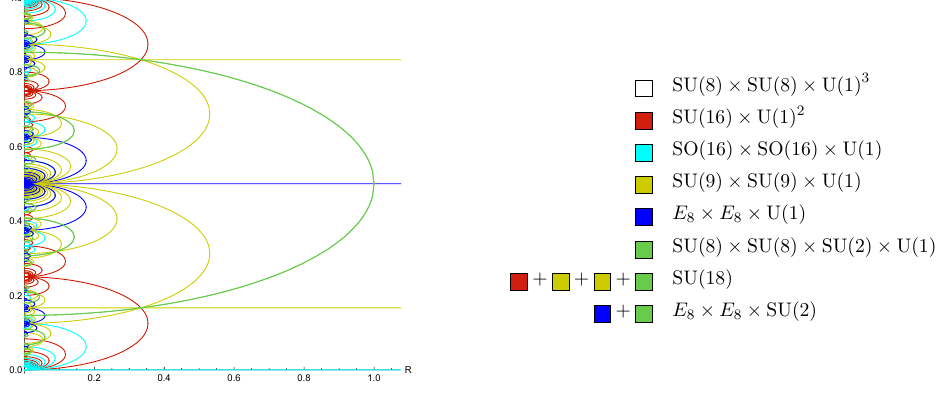
Figure 26. (cid:0) 8 (cid:2) (cid:0) 8 heterotic with Wilson line A I = (( A ) 7 ; 1 (cid:0) A; ( A ) 7 ; 1 (cid:0) A ).